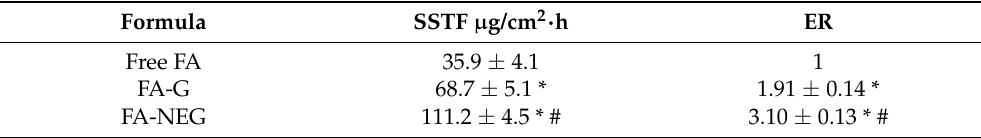
Table 7. Skin permeation parameters of the investigated formulations.